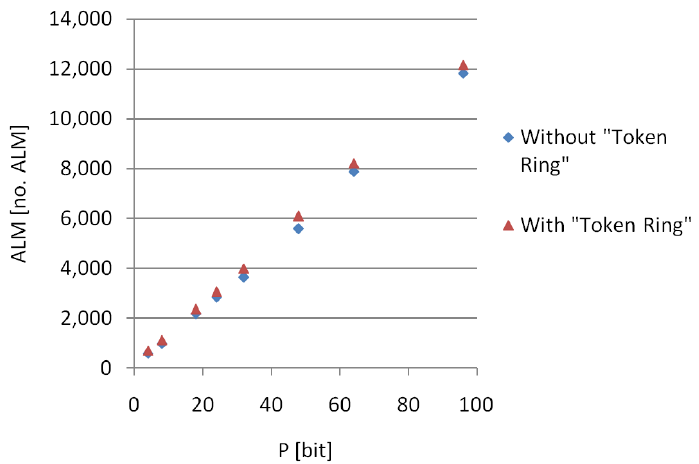
Figure 7. Influence of the P value on the ALM value for a QC-LDPC decoder with an architecture based on Token